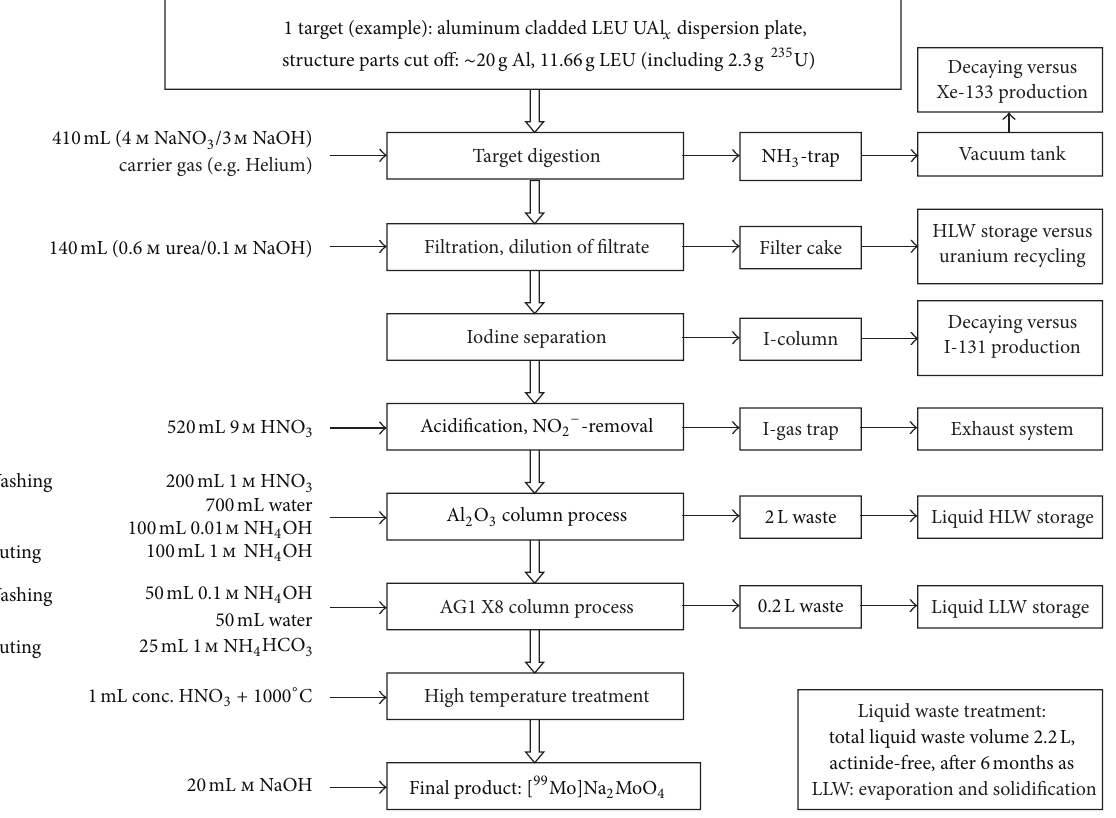
Figure 6: Process scheme for ROMOL LITE, example using one commercially available target plate. The processing of several plates is of course